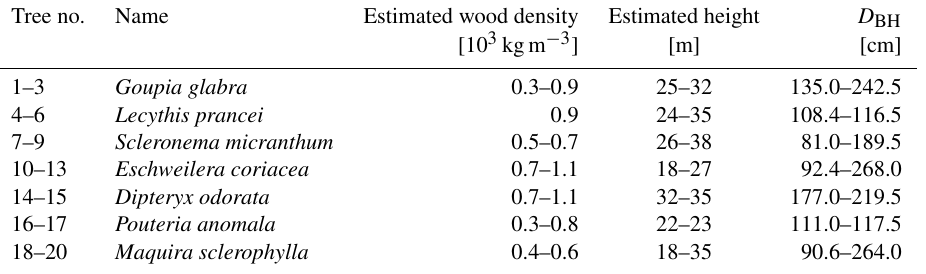
Table 1. Tree characteristics: tree number, scientific name, wood density, estimated total height and diameter at breast height ( D BH ). Tree